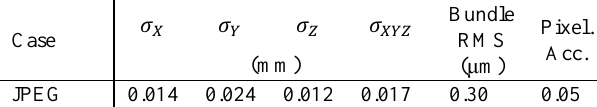
Table 2. Estimates of mean positional standard error for JPEG dataset using all channels for centroiding.